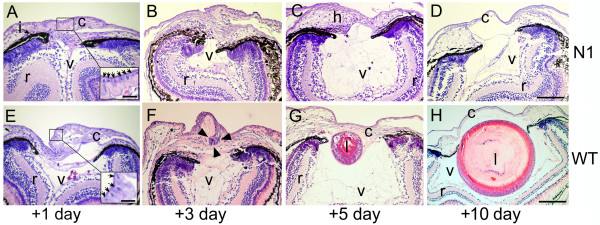
Histology of WT and BMP inhibited (N1) tadpole eyes following lentectomy. (A-D) Representative histological sections through the eyes of transgenic N1 tadpoles 1, 3, 5 and 7 days after lentectomy. Inset in A shows arrows pointing to columnar corneal cells (E-H) Representative sections of wild type eyes at 1, 3, 5 and 7 days after lentectomy. Inset in E indicates columnar corneal cells (arrows). Arrowheads in F indicate the forming lentoid moving into the vitreous. Both transgenic and wild type eyes were subjected to heat shock at -3, 24 and 48 hours relative to lentectomy. Abbreviations: c, cornea; h, hypertrophic cells; i, iris (pigmented epithelium); l, lens; r, retina; v, vitreous. Scale bars in D and H corresponds to 50 μm and applies to all panels. Inset scale bar in A and E corresponds to 10 μm.